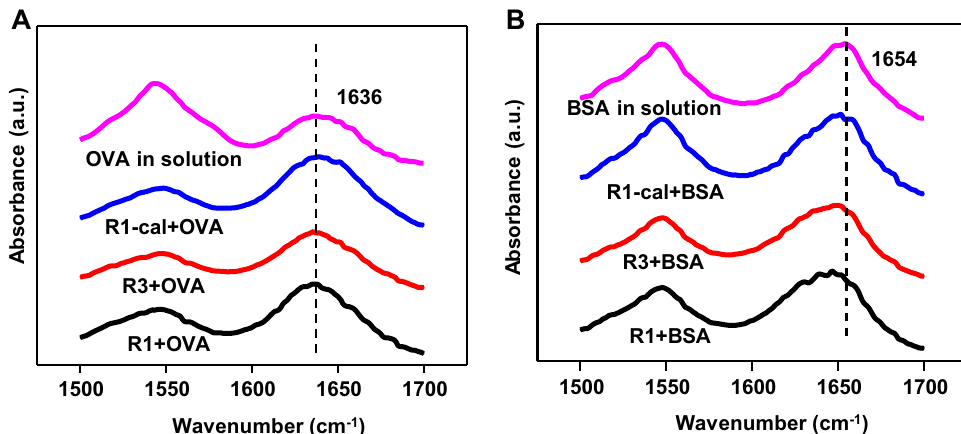
Fig. 6 ATR-FTIR analysis of antigens. ATR-FTIR spectra of A OVA and B BSA in solution and adsorbed by AlOOH